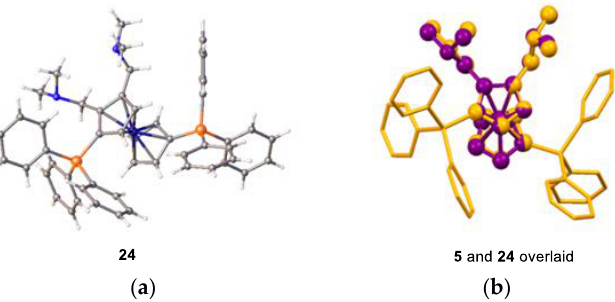
Figure 12. ( a ) ORTEP diagram of bis-2,3-(N,N ′ -dimethylaminomethyl)-1,6-bis-(triphenylsilyl) ferrocene, 24 (showing ellipsoids at 50% probability and the hydrogen atoms removed for clarity) and ( b ) image showing the close overlap of compounds 5 (purple) and 24 (orange), with the similar areas highlighted by balls.